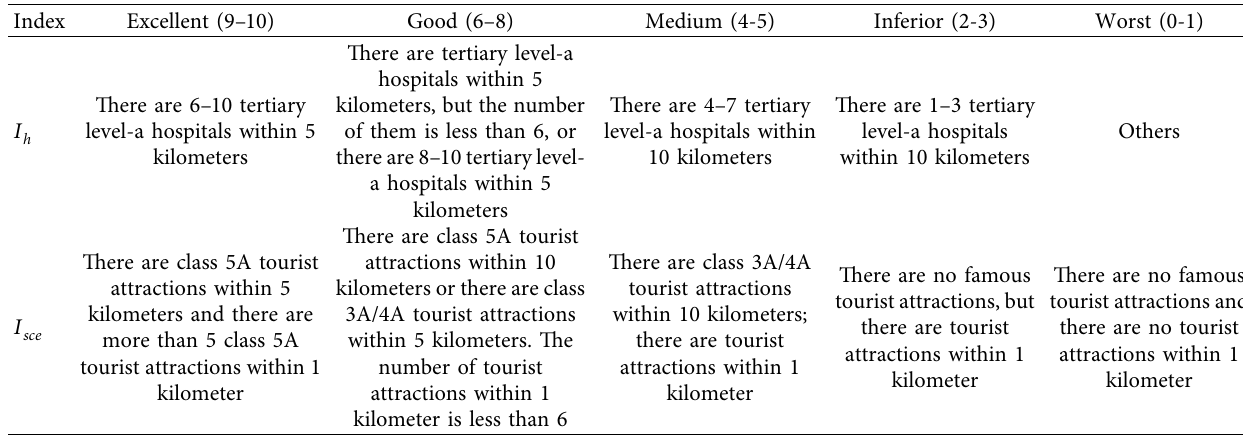
Table 2: Standards for index scoring.